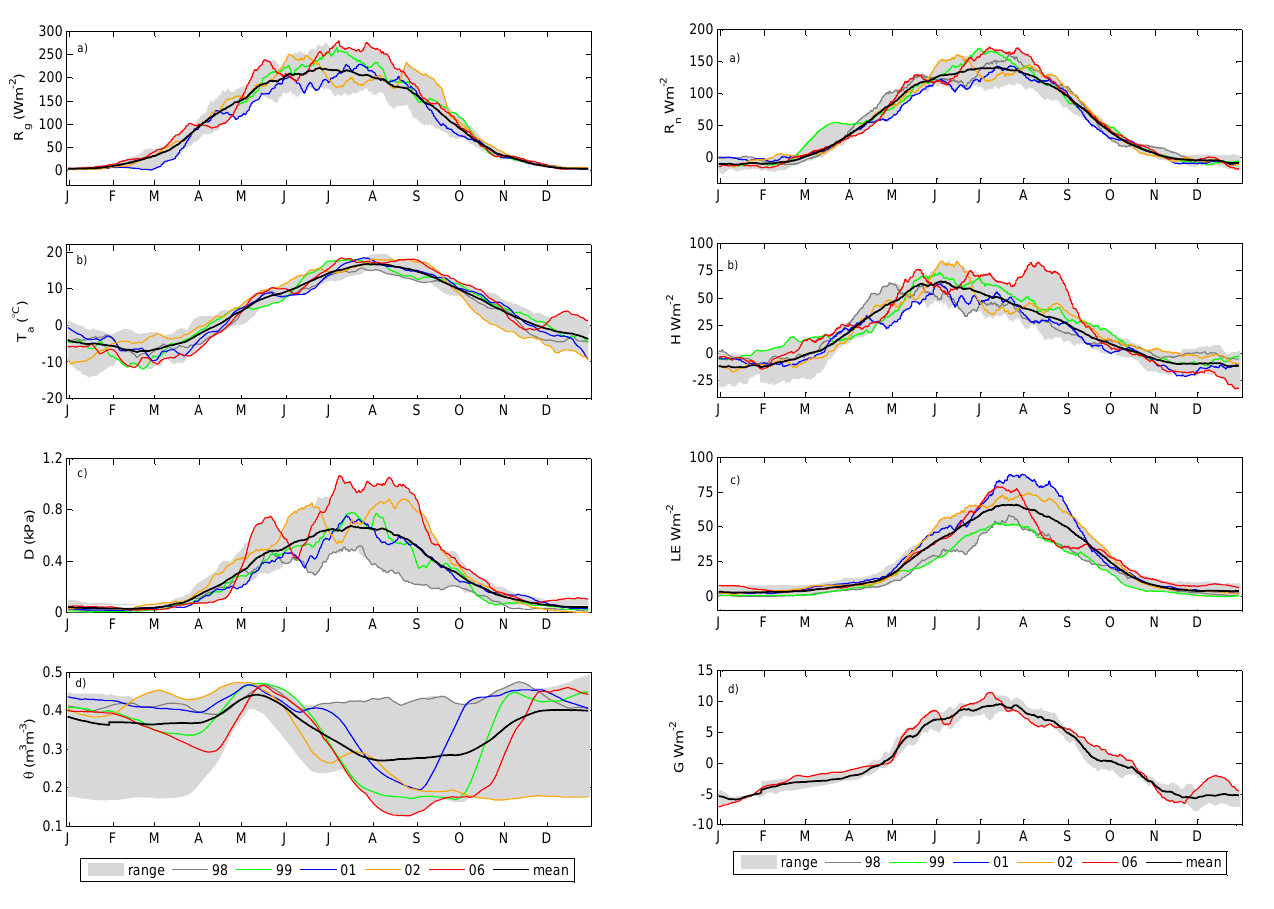
Fig. 2. Seasonal course of (a) global radiation ( R g ), (b) air tem- perature ( T a ), (c) vapor pressure deficit ( D ) and (d) volumetric soil moisture content at 5–25cm depth ( θ ). All data are 30-day running means. The grey area corresponds to the variability range of the 30- day running means during 1998–2008 while the average is given by the thick black line.